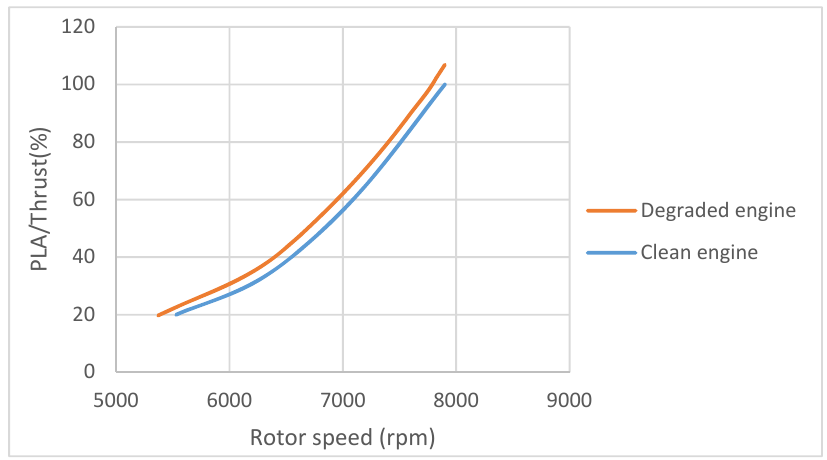
Figure 23. Adjustment of the PLA to rotor speed relationship of the degraded engine.